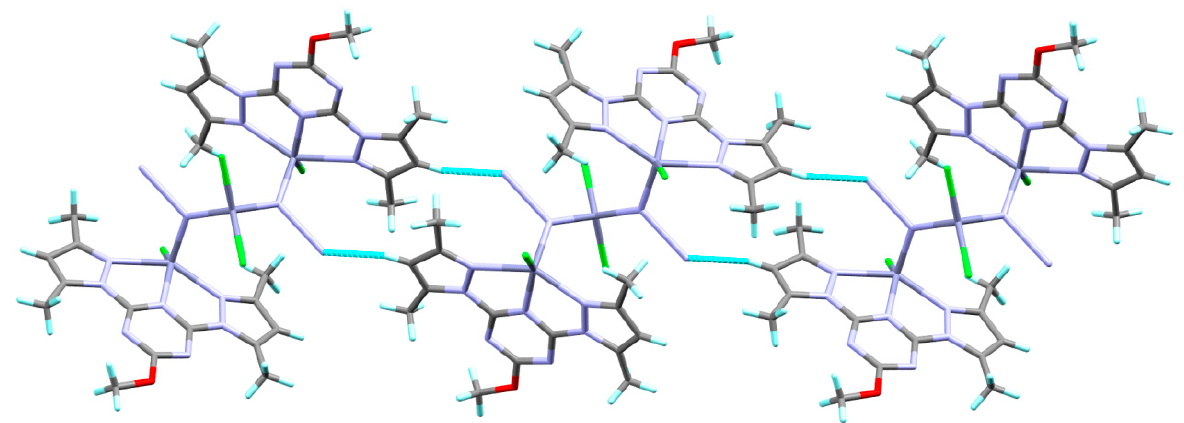
Figure 4. The packing scheme of the [Zn 3 (PMT) 2 (Cl 4 )(N 3 ) 2 ] complex units via non-classical C–H…N interactions along the ac plane.